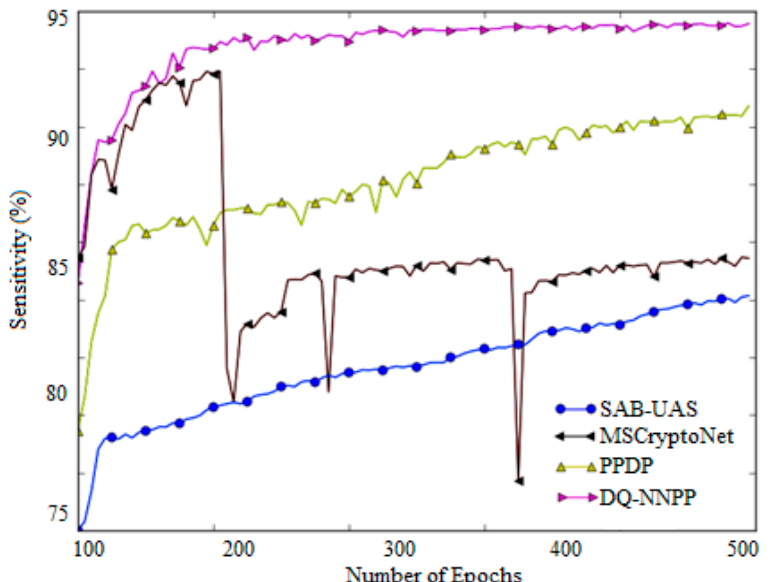
Figure 5. Comparison of sensitivity.